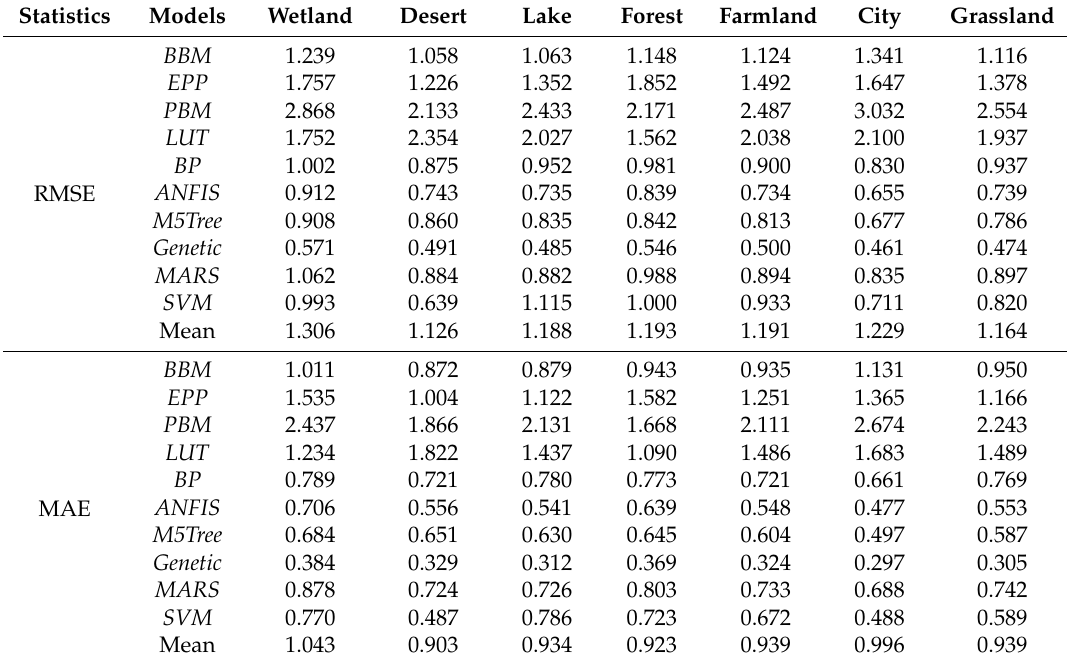
Table 4. The RMSE and MAE for the PAR models in different underlying